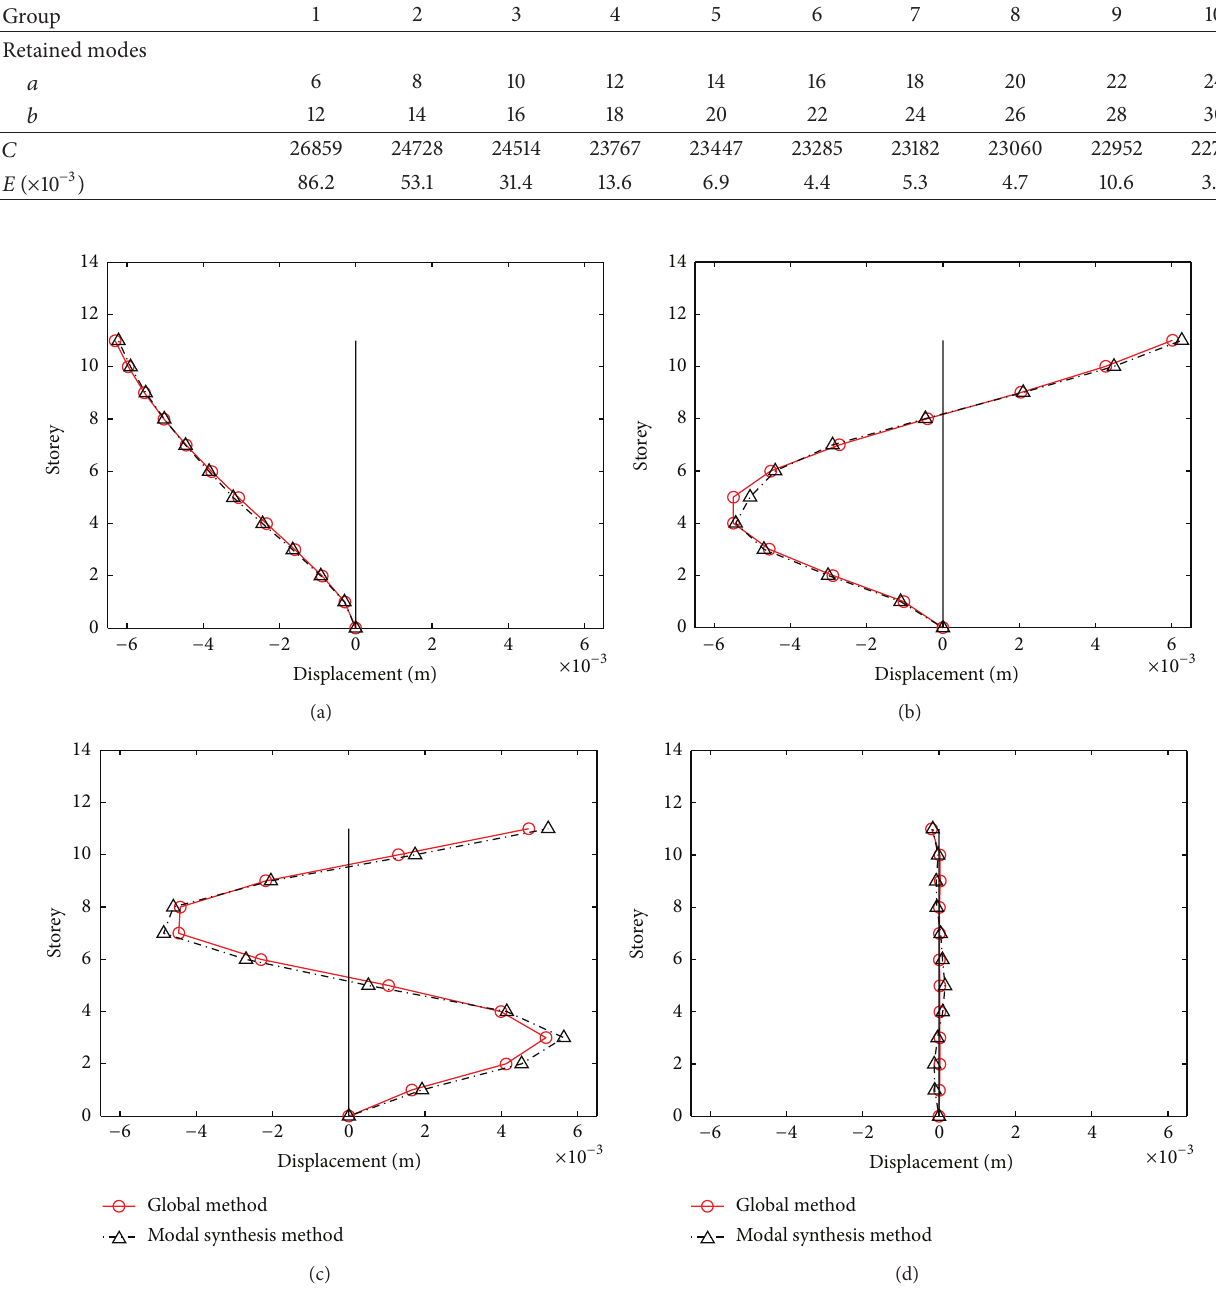
Figure 3: The first 4 mode shapes after modal synthesis (Group